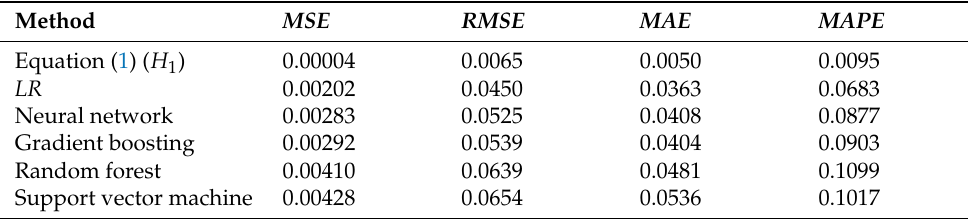
Table 2. Comparison of robustness prediction models (results after cross-validation).